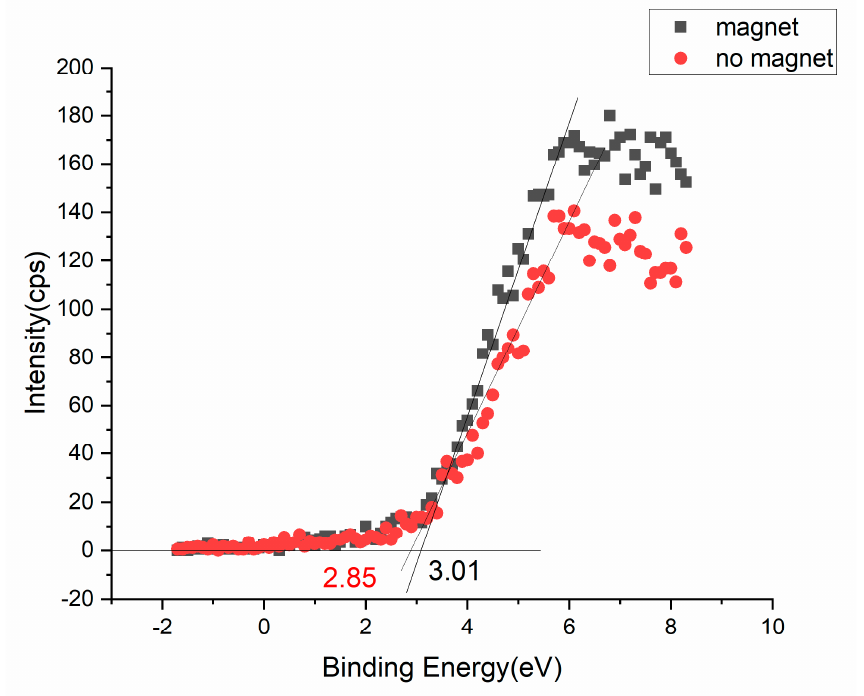
Figure 3. XPS binding energy of nanoparticles collected with sparking discharge. Same sample as for FTIR.